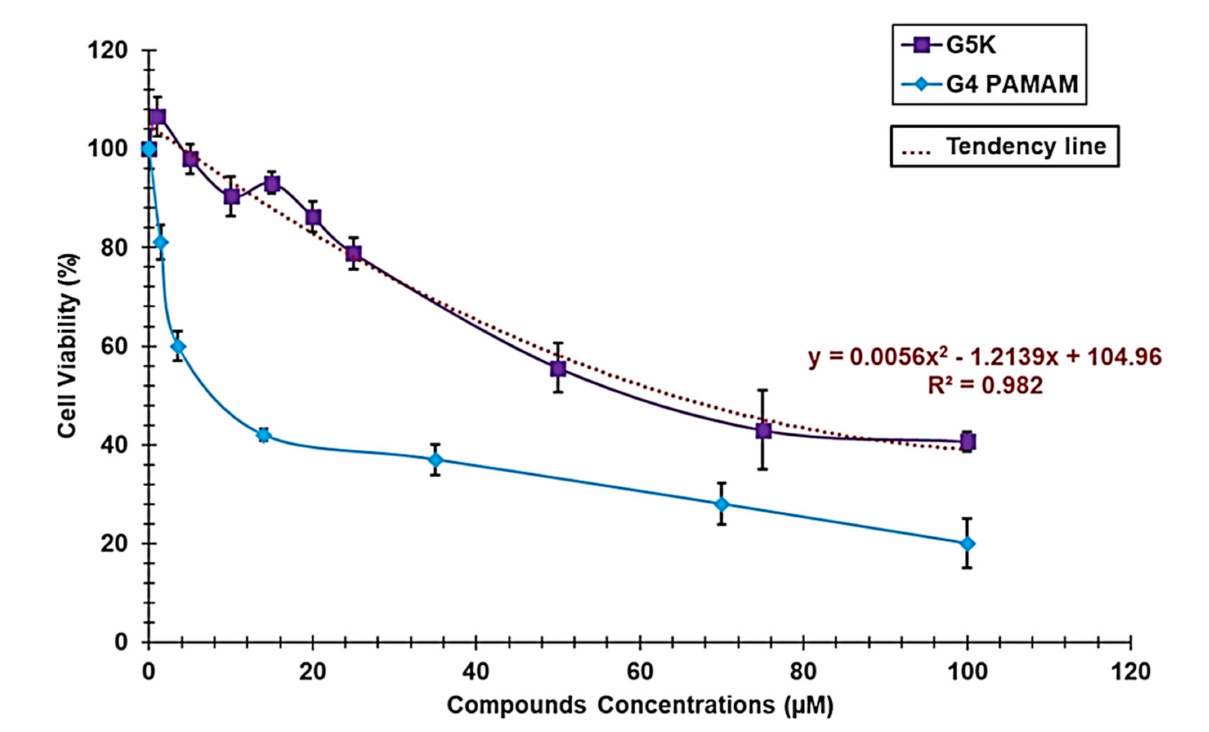
Figure 2. Viability (%) of HeLa cells exposed for 24 h to G5K and G4-PAMAM-NH 2 (0–100 µ M) and the polynomial trend line associated with the curve obtained for G5K with Equation (6) used to determine the LD 50 of G5K.